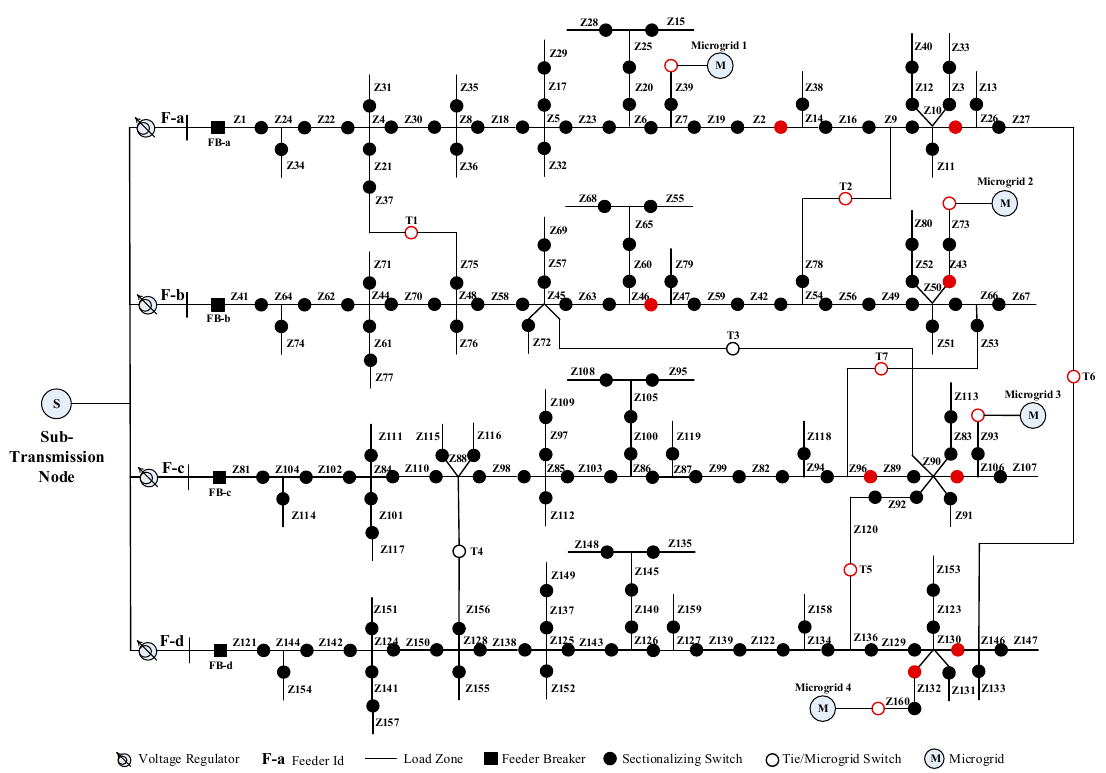
Figure 6. One-line diagram of the 4-feeder 1069-node test system. Figure 6. One ‐ line diagram of the 4 ‐ feeder 1069 ‐ node test system.